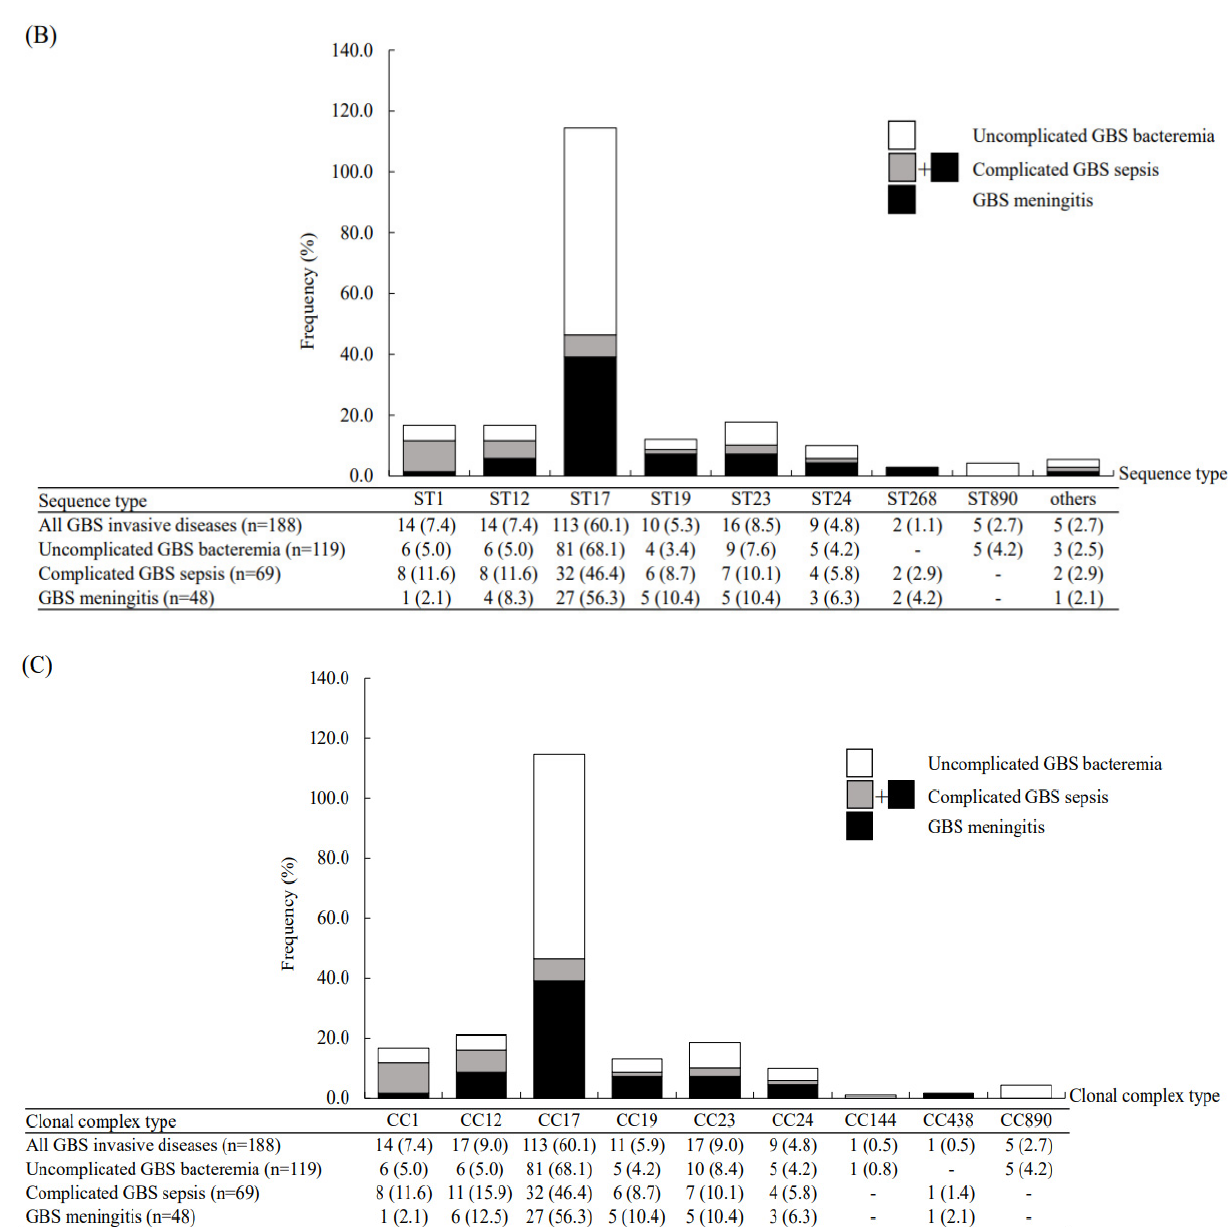
Figure 1. Distribution of all group B streptococcal (GBS) invasive diseases in neonates between 2003 and 2020, stratified by uncomplicated GBS bacteremia, complicated GBS and GBS meningitis: ( A ) The distribution of capsular serotypes; ( B ) the distribution of sequence types (ST); ( C ) the distribution of clonal complex (CC) types.